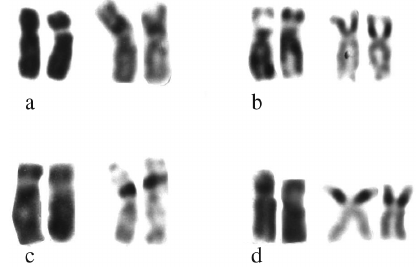
Figure 3 - NOR-bearing chromosomes. Giemsa and Ag-NOR staining. Note the NORs in an interstitial position on the short arm in pair 11 in S. fuscus (a),inpair10in S.variabilis (b)and S.leucostictus (c),andinpair8 in S. pictus (d).